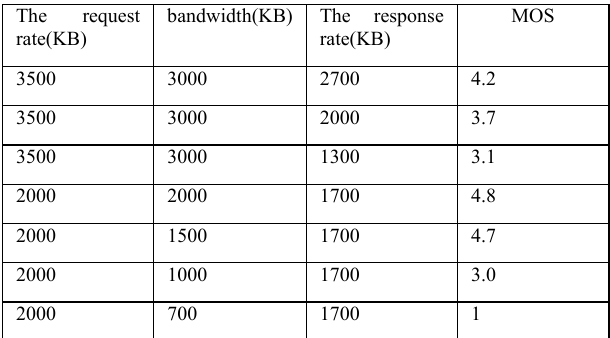
TABLE I. The example of test Data The